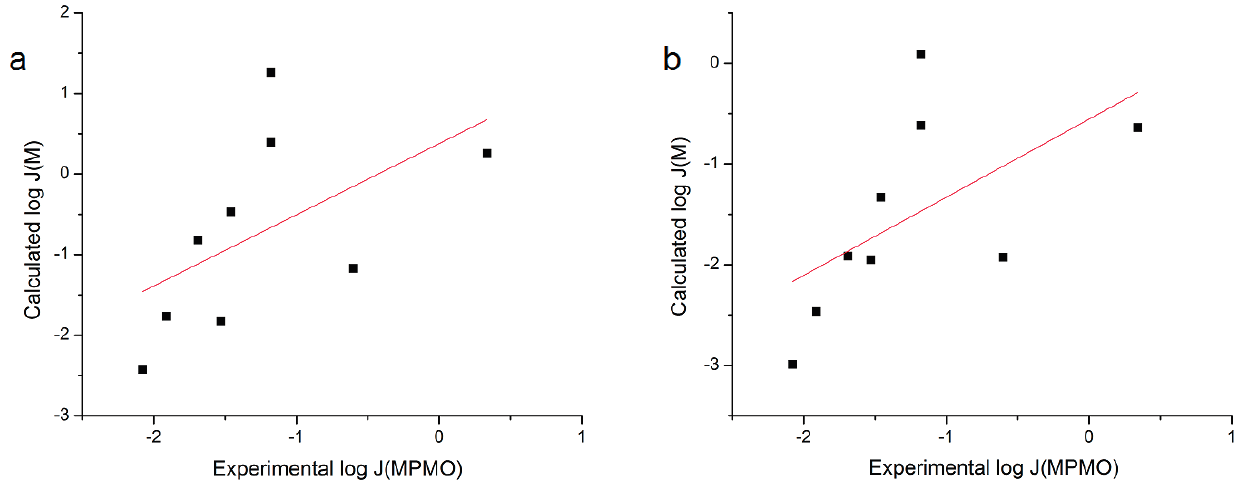
calculated with Sloan, et al. surrogate review coefficients [1] M using ( a ) S or ( b ) S MPMO 7.4 1.0